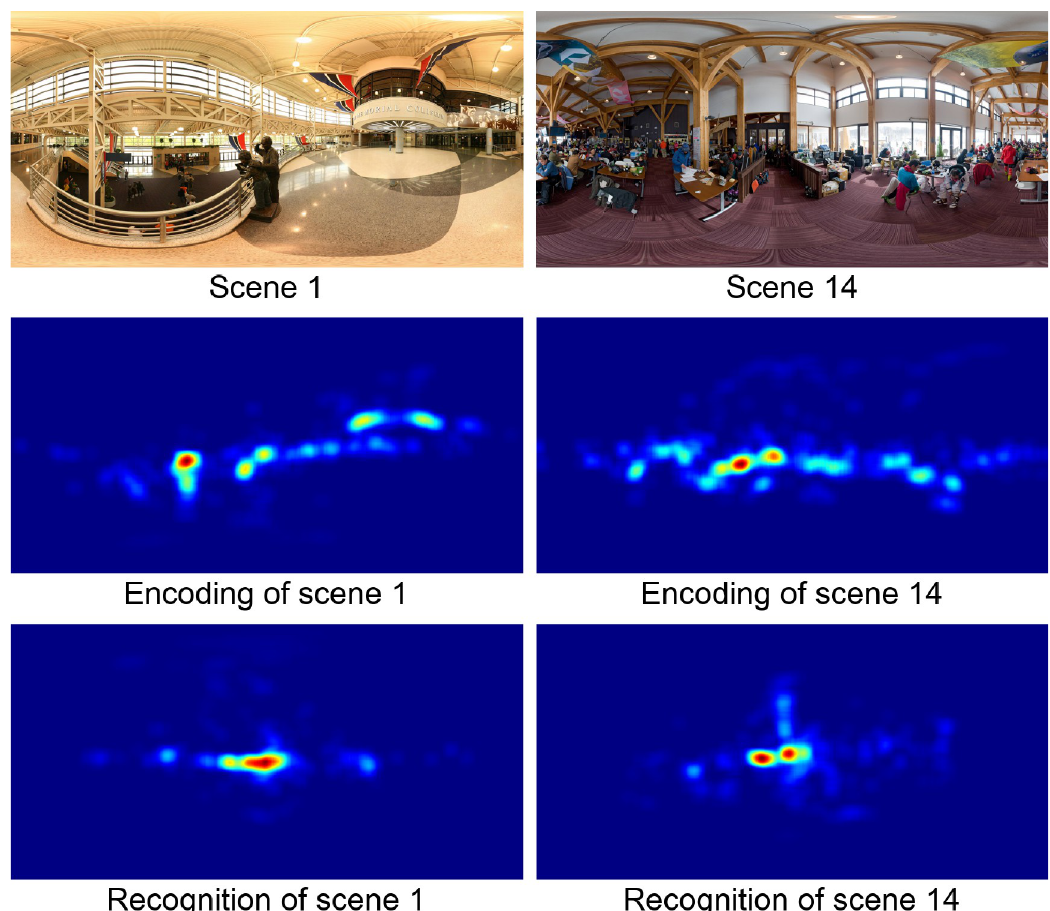
Fig 3. Fixation heatmaps for the encoding and recognition of two sample scenes.